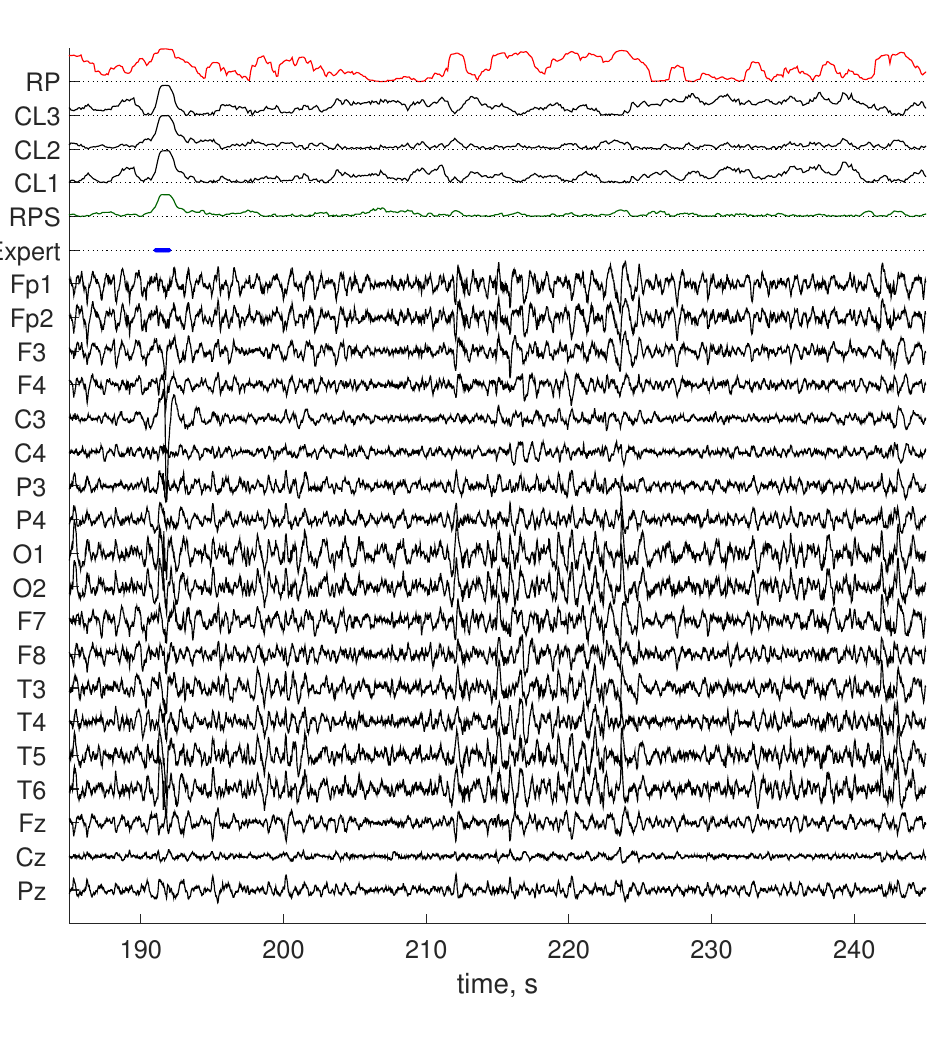
Figure 6. Scoring obtained by the benchmark method (RP) and RPs (RPS) on data from the InSleep dataset. Normalized distances to three clusters obtained for this recording with RPs (CL1–3) are shown, as well. Artifacts (Expert) are denoted with a solid blue line.